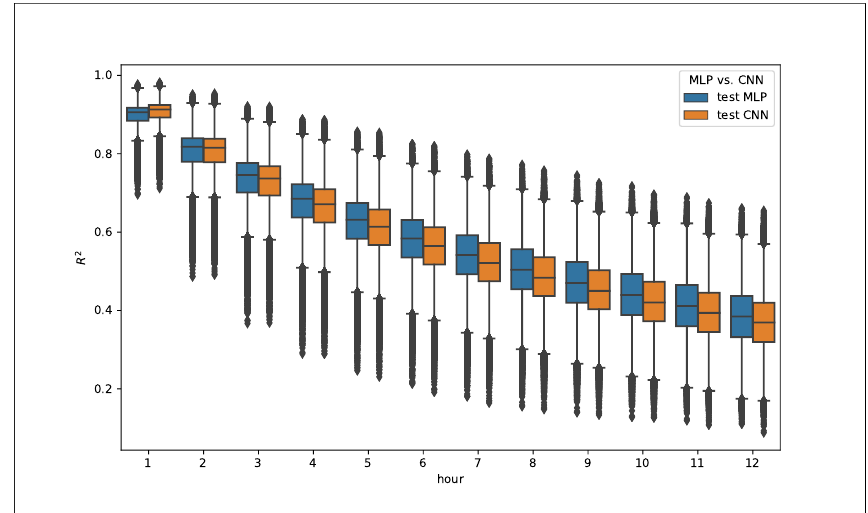
Figure 6. Boxplot comparing the hourly distribution of R 2 error results between the MLP and CNN methods.